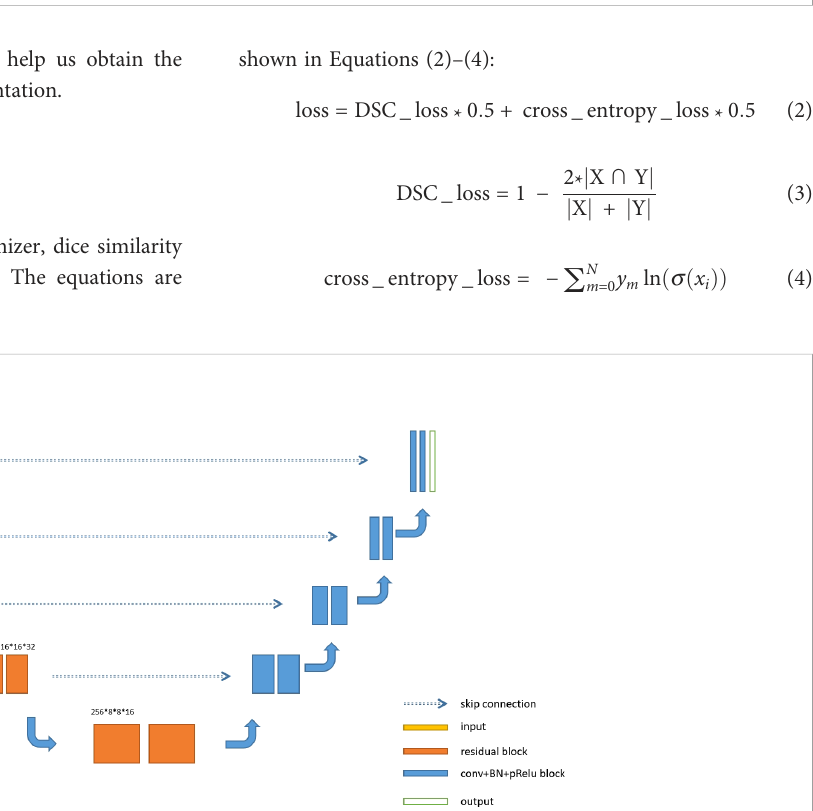
FIGURE 3 Work fl ow of data